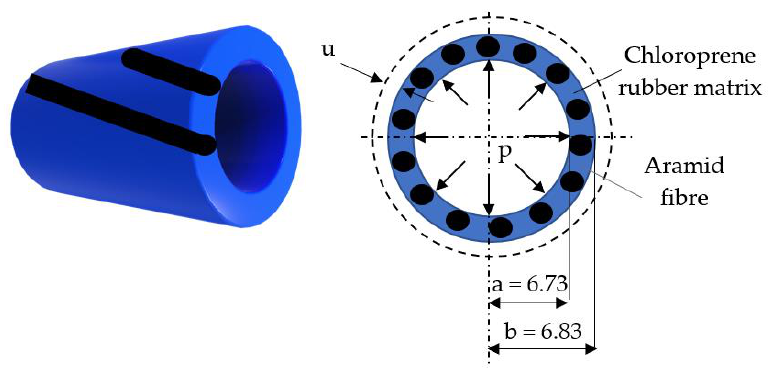
Figure 3. Model of the thin-walled tube.